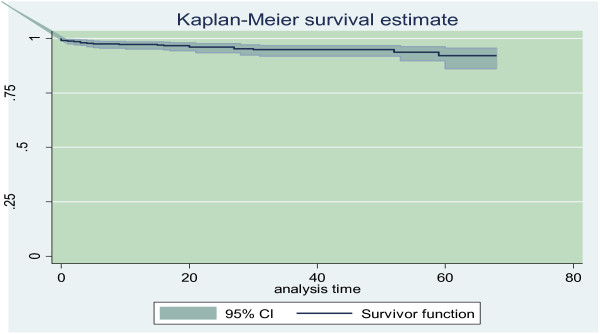
Overall Kaplan - Meier probability of survival curve with 95% confidence intervals of children on ART, Mekelle Hospital, and Northern Ethiopia.